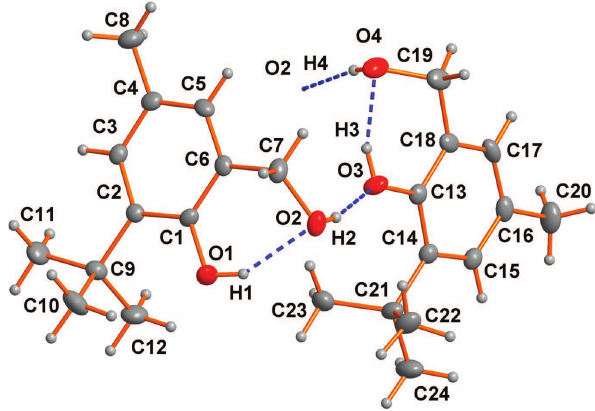
Table 2: Fractional atomic coordinates and isotropic or